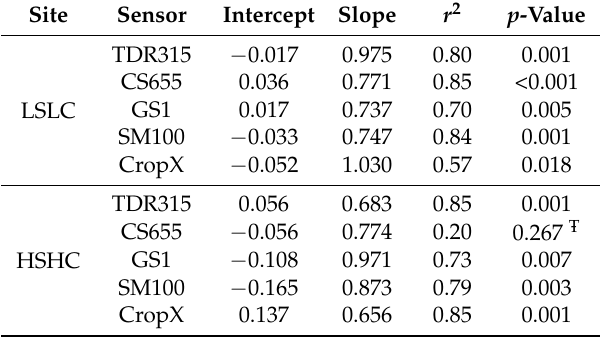
Table 4. Parameters and the p -values of the linear regression equation: θ ref = Slope × (sensor θ v ) +